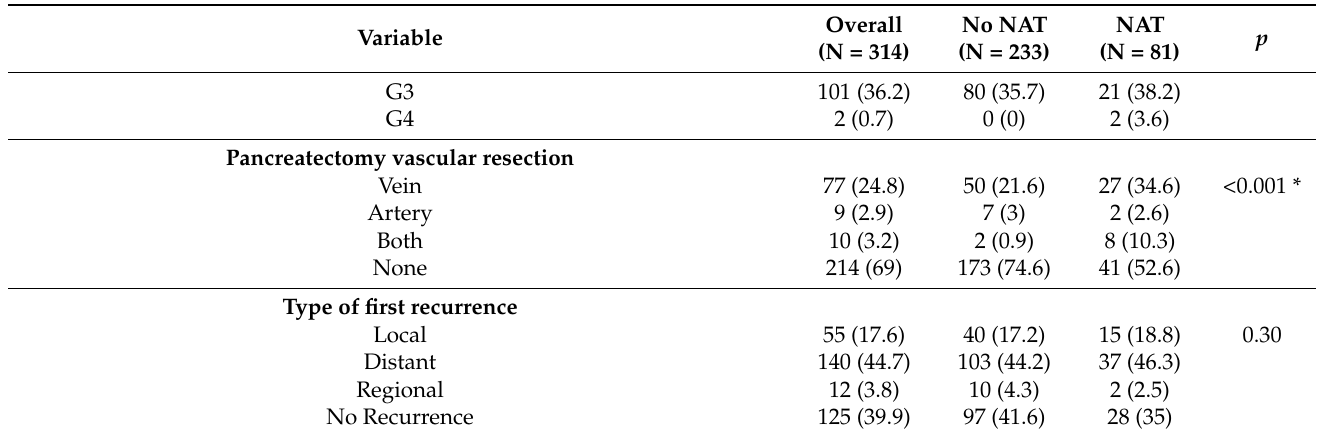
Table 1. Cont. Variable